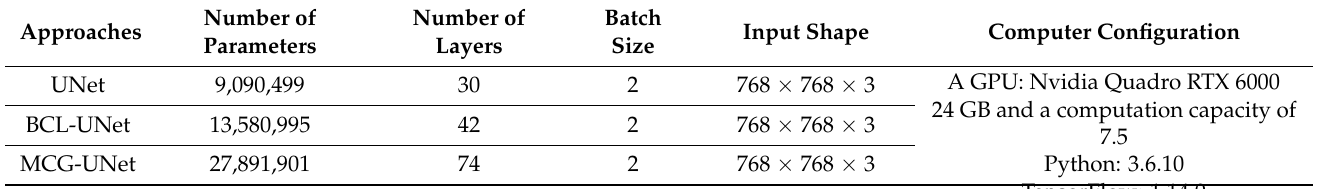
Figure 6. ( a ) Structure of BConvLSTM in the expansive part of the BCL-UNet model, and ( b ) BConvLSTM with the SE module in the expansive part of the MCG-UNet model ( b ). Table 1. Detailed configurations of all